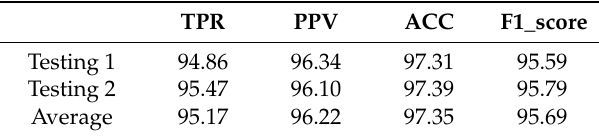
Table 6. Accuracies of shadow detection by our method (unit: %).